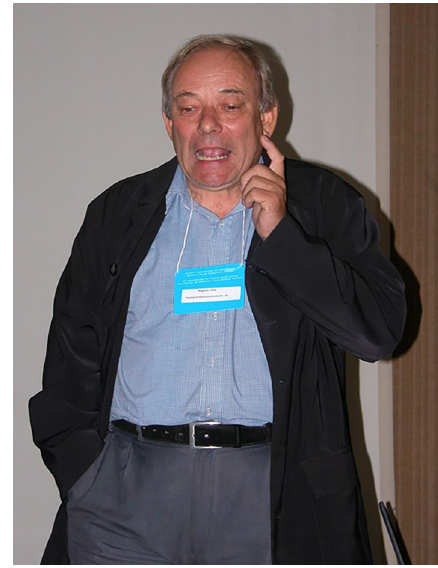
Figure 7. Mogens was a gifted speaker with the ability to deliver talks at a high academic level with many subtle jokes. Here, Mogens is answering questions after an invited talk at the yearly meet- ing of the Brazilian Physiological Society in Ribeirão Preto, Brazil, in